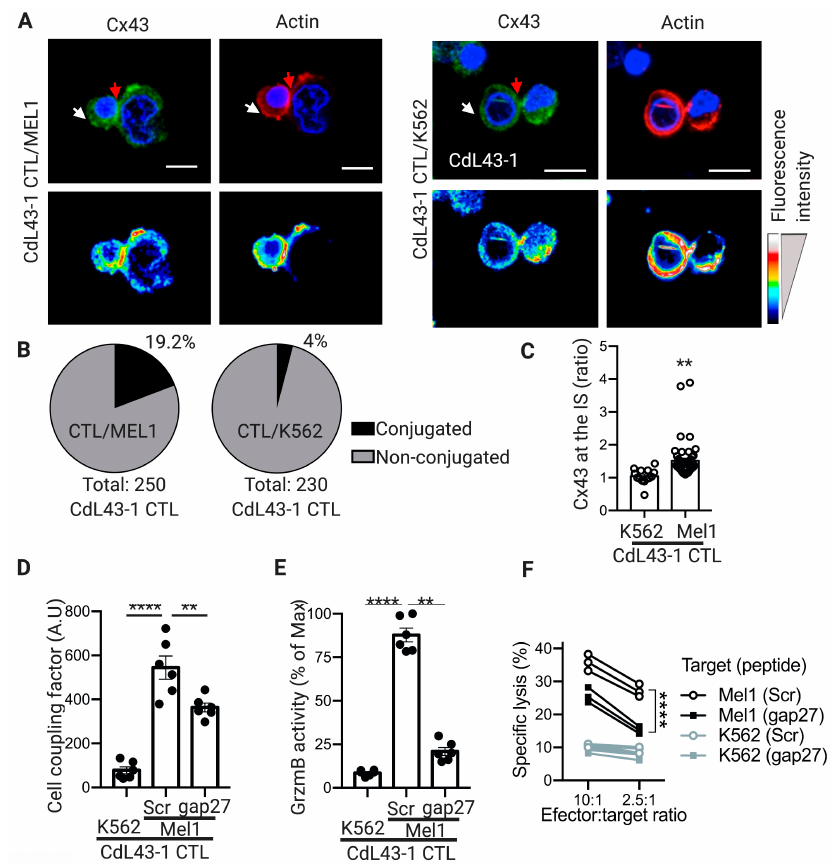
Figure 4. Connexin-43 (Cx43) localizes at cytotoxic immunological synapses (IS) and contributes